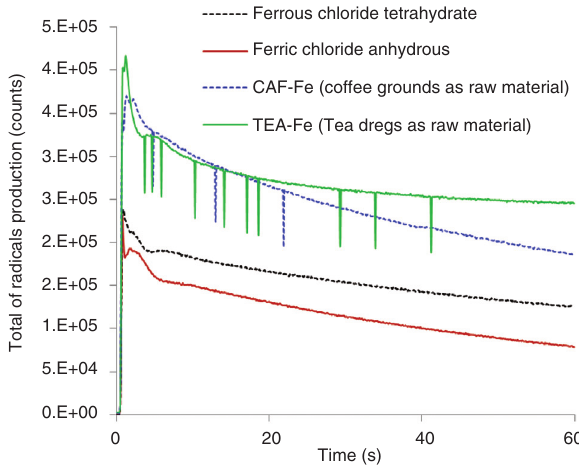
Figure 5 Total amount of hydroxyl radicals generated (as light) during 60 s of reaction of 1 mm of hydrogen peroxide with 0.1 mm of Fe as ferrous chloride tetrahydrate, ferric chloride anhydrous, CAF-Fe and TEA-Fe catalysts measured by a Luminescencer Octa AB-2270 using